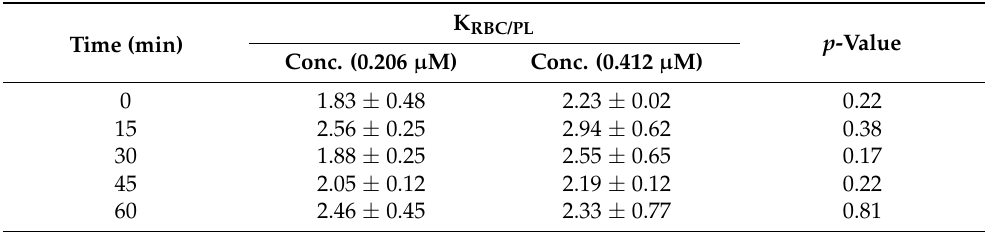
Table 1. K RBC/PL of PSTi8 in rat whole blood at 0.206 µ M and 0.412 µ M. Data are presented as the mean ± SD with n = 3.